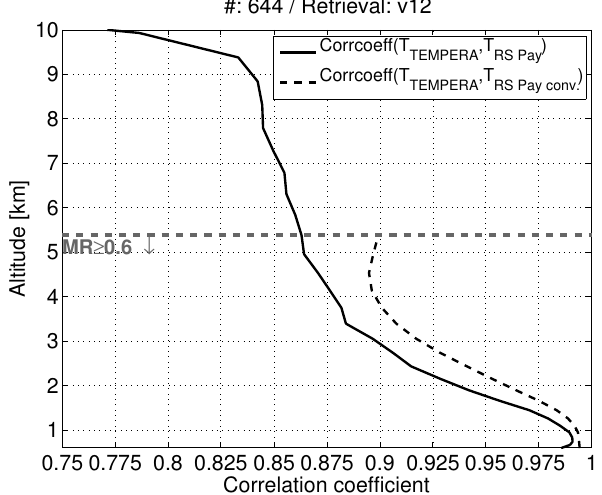
Fig. 13. Correlation coefficient of the comparison for 644 profiles (January, 1 to December, 13 2012) between TEMPERA and radiosonde data from Payerne over an altitude range from ground (0.575 km) to 10 km. The horizontal grey line indicates the region where MR=0.6. Correlation coefficient of the comparison between TEMPERA and the unconvolved (black line) and convolved (dashed black line, altitude region with MR ≥ 0.6) radiosonde data from Payerne.